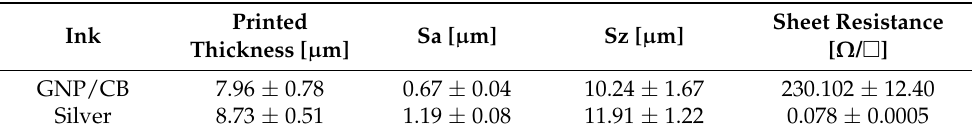
Table 1. The printed properties of the Carbon and Silver print. Printed thickness is taken from n = 10 measurements and shown ± s.d. Average surface roughness (Sa) and Peak-peak surface roughness (Sz) is shown from n = 8 measurements and shown ± s.d. Sheet resistance was taken 40 measurements from n = 8 samples for the carbon ink and 30 measurements from n = 6 samples for the silver and shown ±